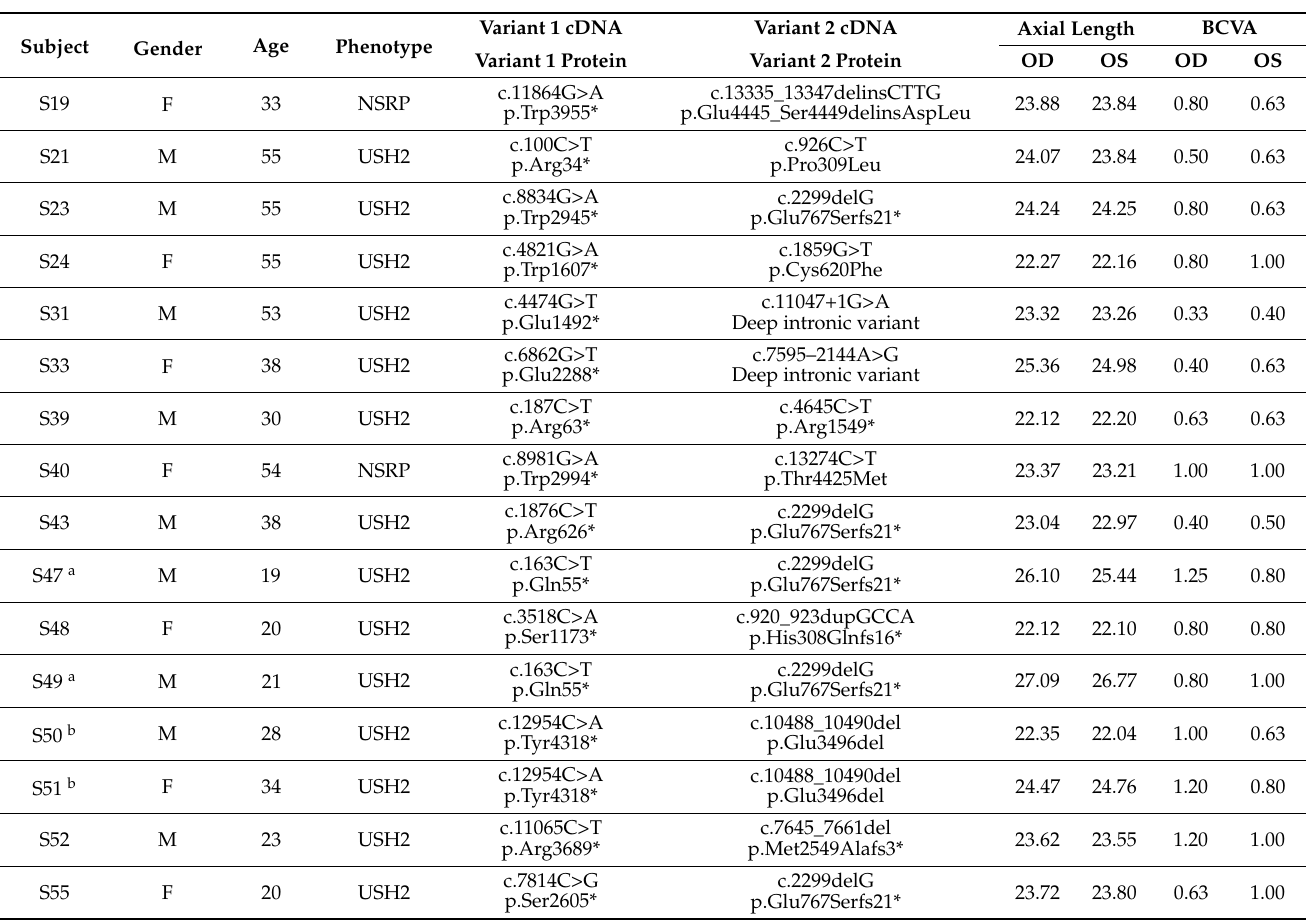
Table 1. Summary of subject demographics, genetic results and clinical characteristics. Genetic and clinical data of the 16 patients forming the study cohort with biallelic pathogenic variants in USH2A are shown. Axial length measurements are provided in millimetres. Best-corrected visual acuity (BCVA) is shown in Snellen decimal format with normal defined as ≥ 0.80 (6/7.5). F, female; M, male; NSRP, non-syndromic retinitis pigmentosa; OD, right eye; OS, left eye; USH2, Usher syndrome type